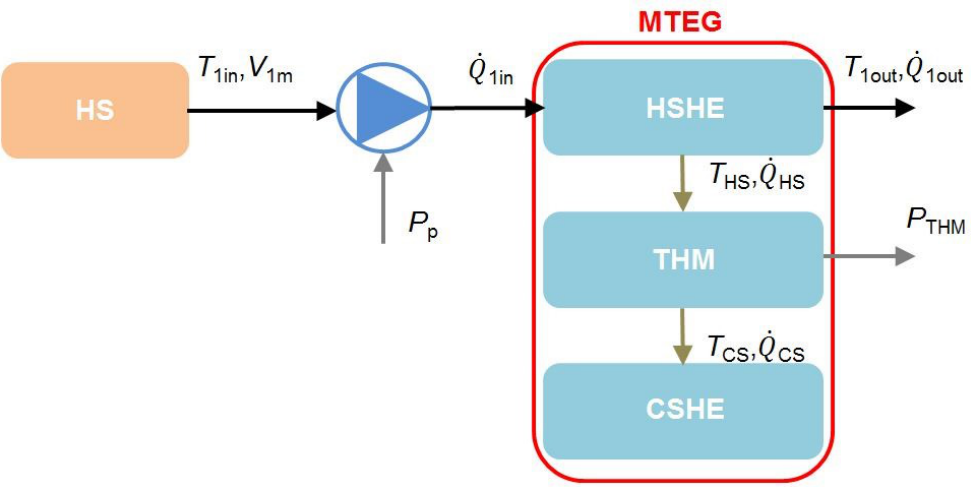
Figure 1. Heat flux distribution in the MTEG system with the thermoelectric